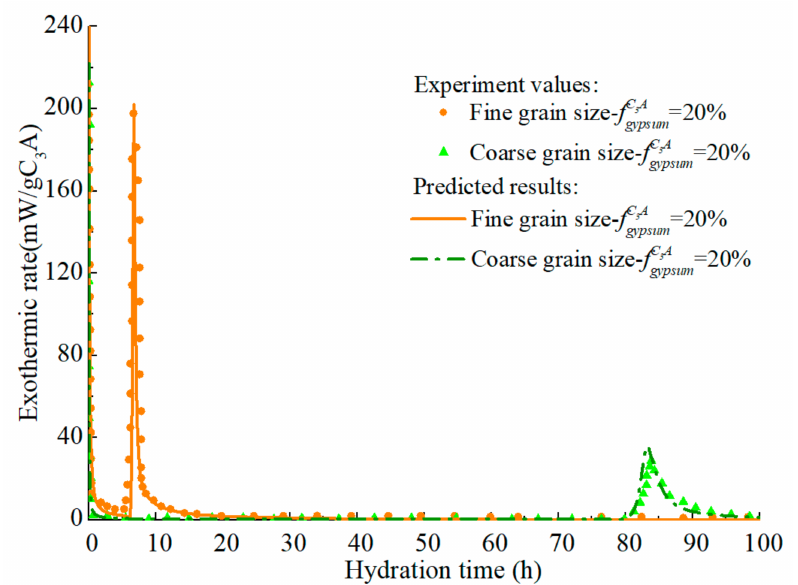
Figure 16. Hydration heat release rate of C3A in C3A- gypsum system with different fineness (w/c = 1.0).